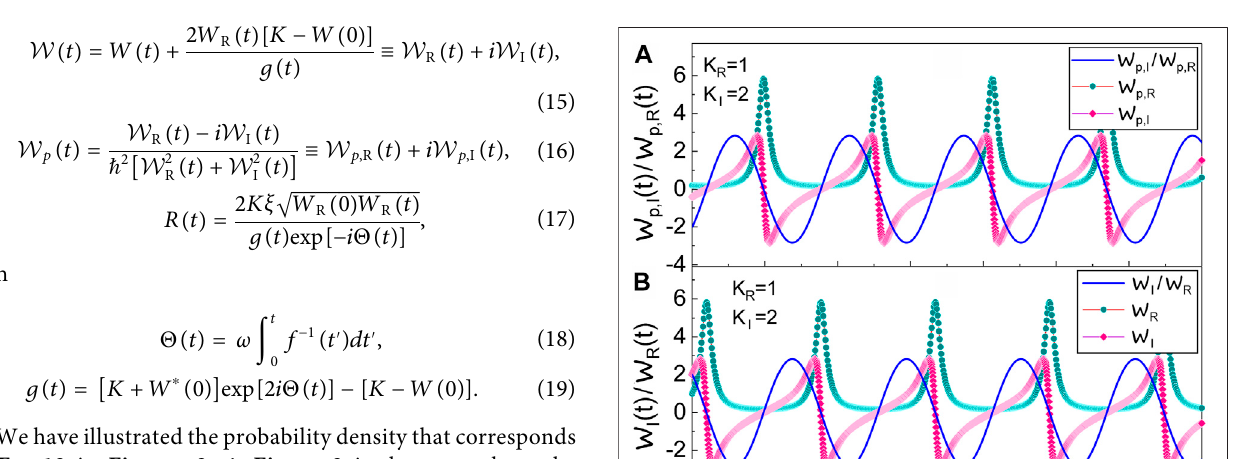
evolutions of W p, R ( t ) and W p, I ( t ) given in Figure 5 are the same as those of W p ,R ( t ) and W p ,I ( t ) given in Figure 2 , respectively, except for